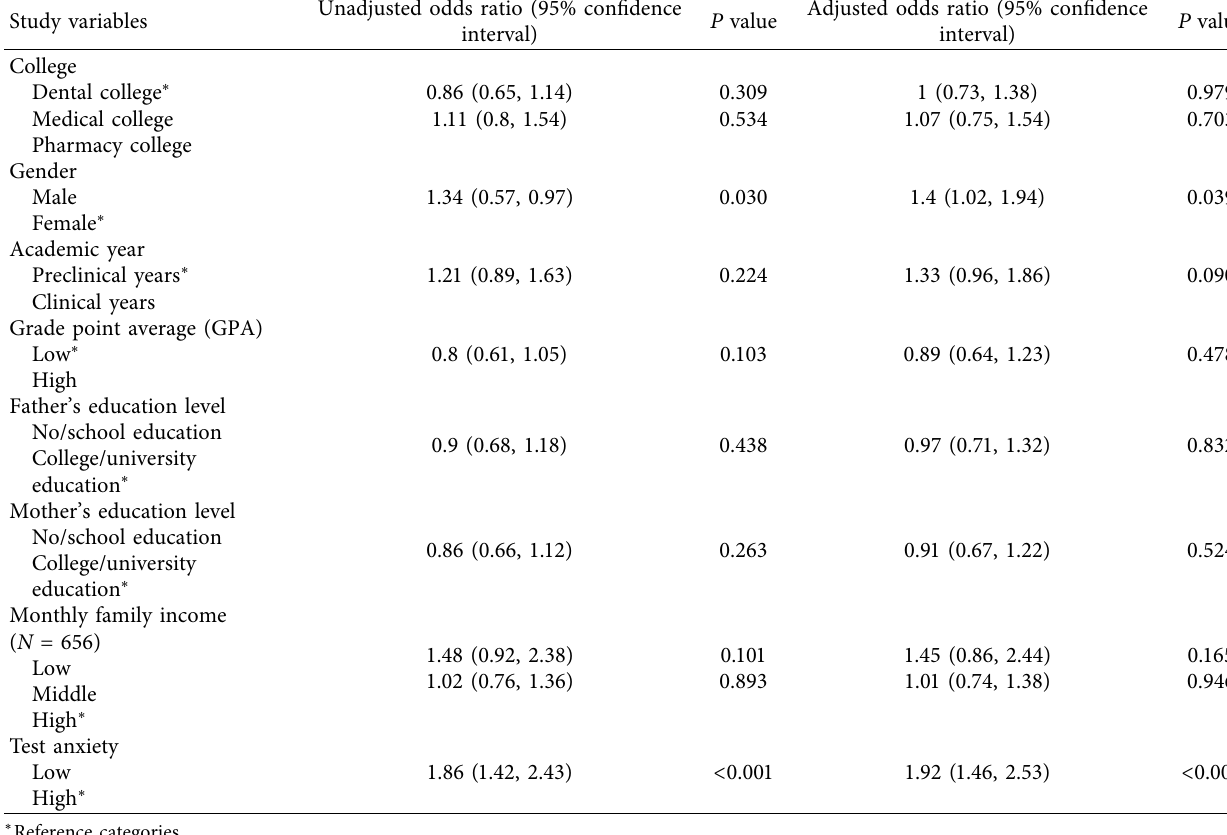
Table 4: Association of different factors with TMD in study participants.